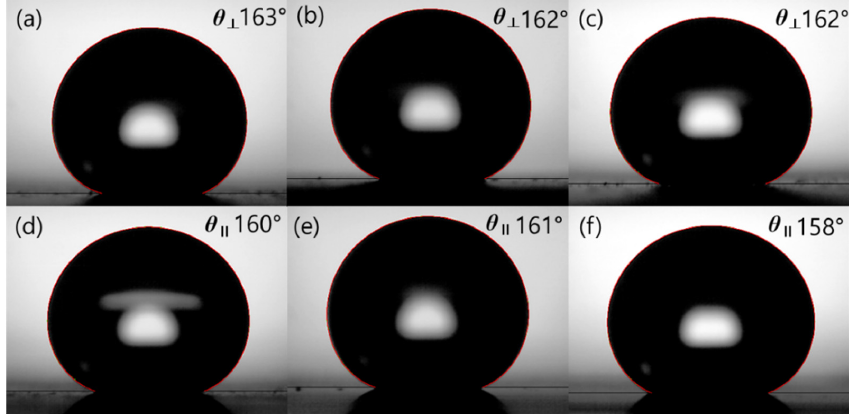
Figure 8. Water droplet contact angles on the microscale groove pattern surfaces with coating in the direction parallel to groove patterns with ( a ) 10 μ m; ( b ) 20 μ m; and ( c ) 30 μ m depths, and in the direction perpendicular to the groove patterns with ( d ) 10 μ m; ( e ) 20 μ m; and ( f ) 30 μ m depths. After coating, all apparent contact angles were higher than 150 ◦ and ∆ θ was very small,